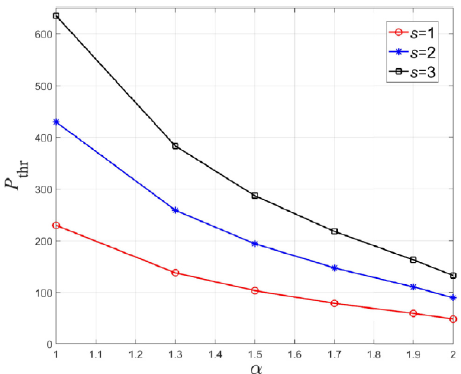
( s ) ( α ) , below which Equation (38) thr